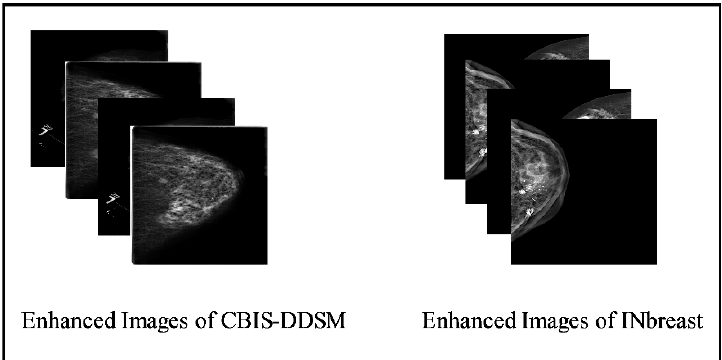
Figure 4. Visual illustration of proposed enhancement technique .